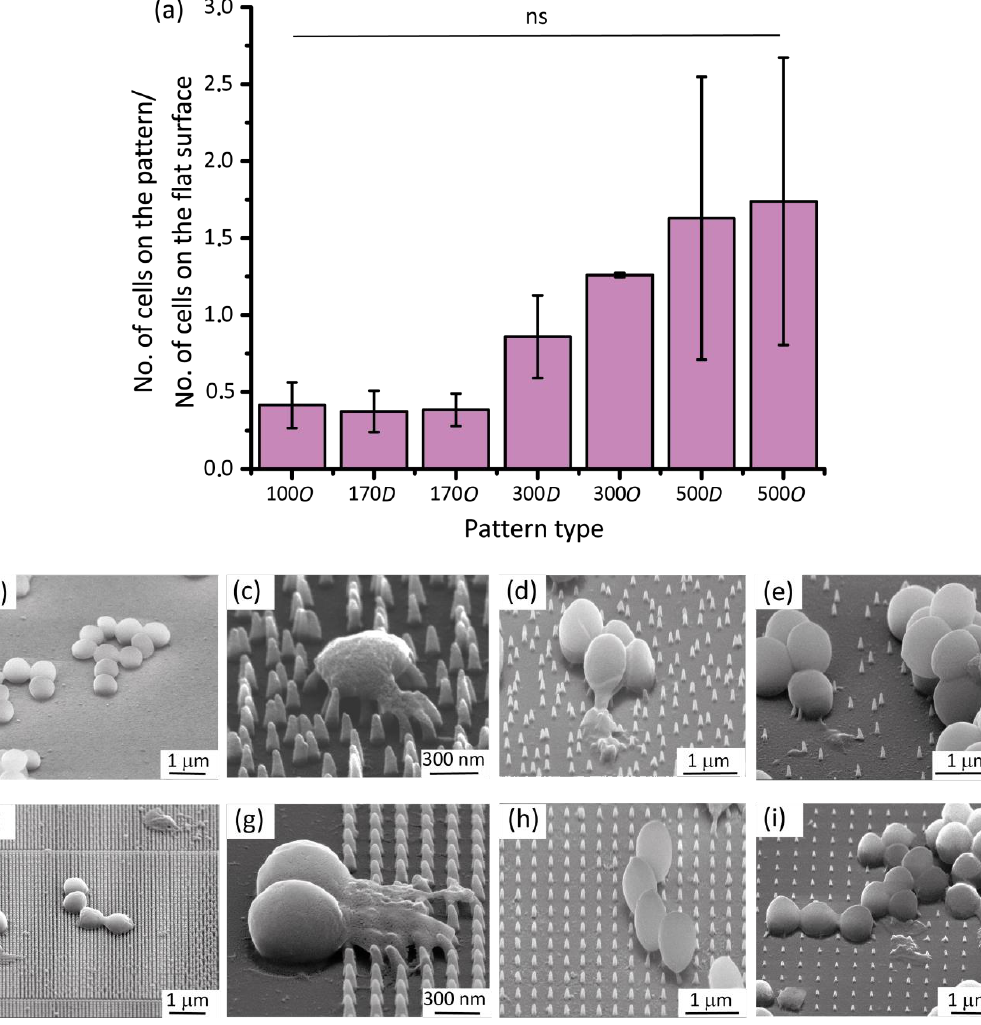
Figure 3. ( a ) The ratio of the bacterial cells attached to the nanopatterns to those attached to similar flat areas. No significant difference in that ratio for different types of nanopattern indicates that bacterial adhesion is similar between different groups; The SEM images of S. aureus bacteria on ( b ) the control Si surface; ( c ) 170 D ; ( d ) 300 D ; ( e ) 500 D ; ( f ) 100 O ; ( g ) 170 O ; ( h ) 300 O ; ( i ) 500 O at 52° tilted view. The damaged bacterial cells can be identified with irregular and unrecognizable morphologies as compared to normal cells on flat surfaces.